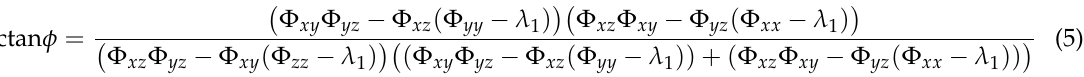
Figure 1. Coordination rotation by eigenvector V 1 decomposition; Angle φ is the coordination rotation angle.